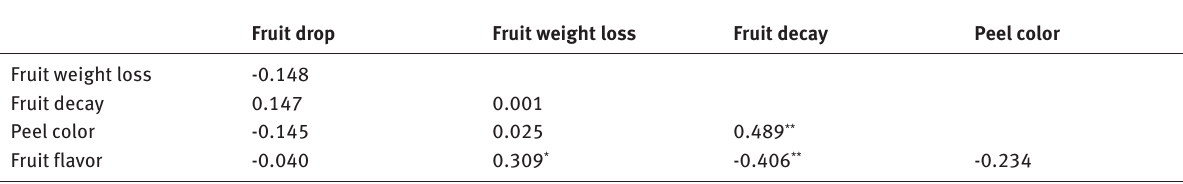
Table 2: Similarity coefficients among fruit traits of ‘Thompson Navel’ orange